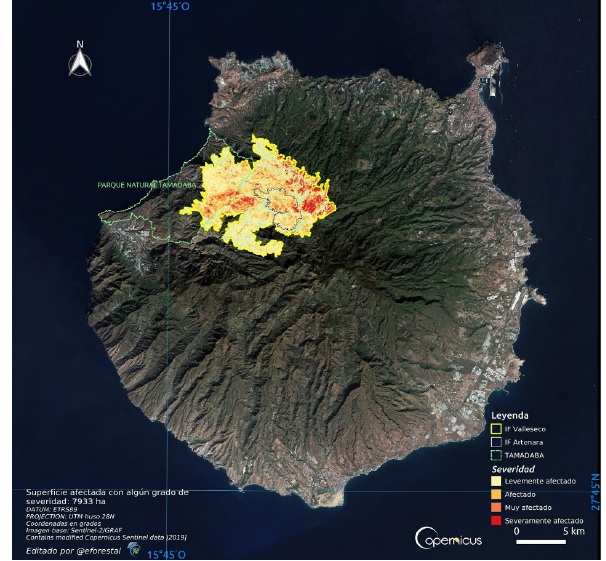
Figure 3. Fires in Gran Canaria and their severity, 25 August 2019. Source: Copernicus Service information [2018] for Copernicus Service Information. Edited by: @eforestal, member of Copernicus Academy (https://twitter.com/eforestal/status/1168965512564547584).